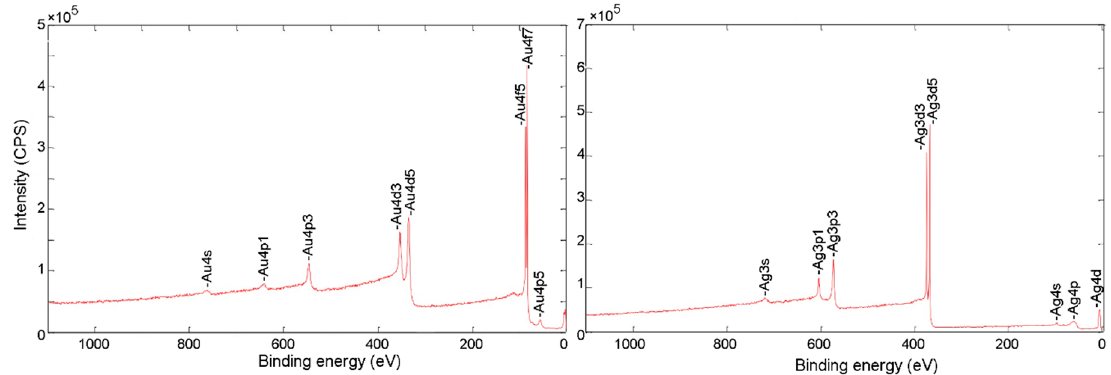
Figure 3. Elemental analysis of parallel electrodeposited layers of gold and silver (XPS spectra).